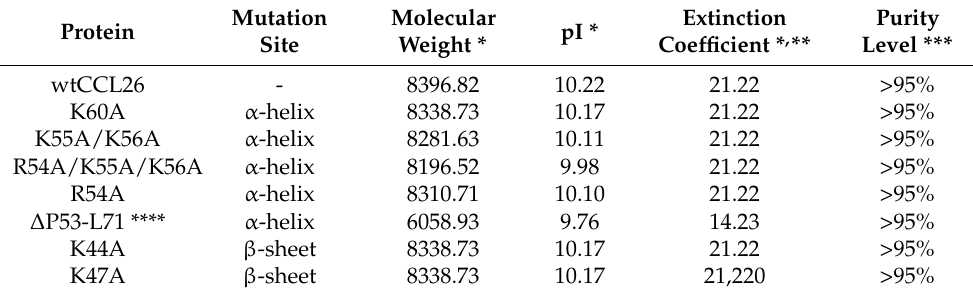
Table 1. Physical and chemical characteristics of wtCCL26 and its mutants that were expressed and purified; abbreviation: pI, isoelectric